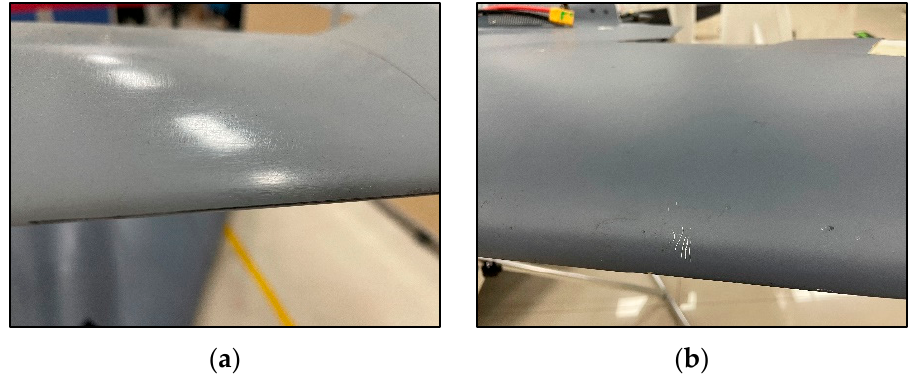
Figure 1. Wing surface defects. ( a ) wing of conventional configuration UAV; ( b ) wing of flying wing UAV.